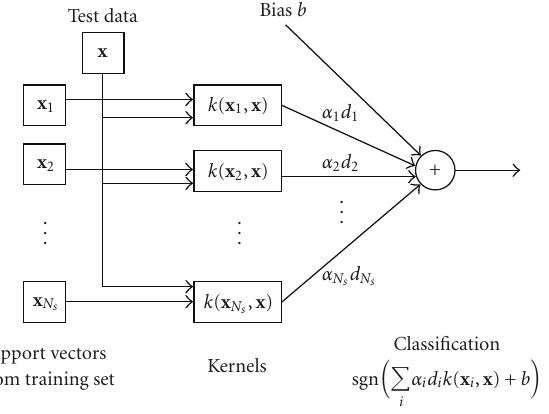
Figure 16: Block diagram of an SVM classifier for a two-class case.